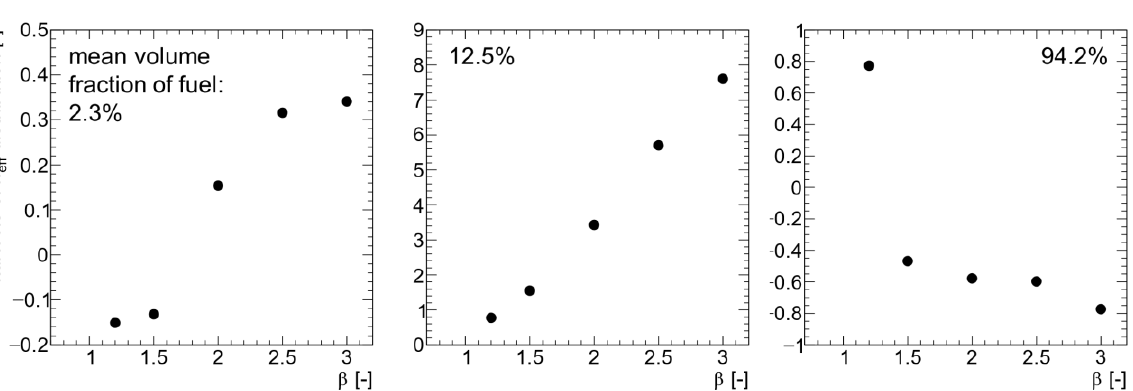
distribution for different mean volume fraction of fuel. The other Figure 6. Kurtosis of the k eff meanings of figures are the same as Figure